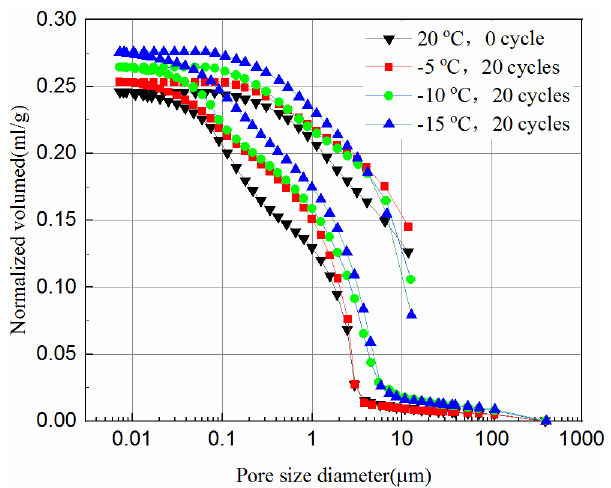
Figure 10. Intrusion and extrusion curves of 7-day samples at different cooling temperature.